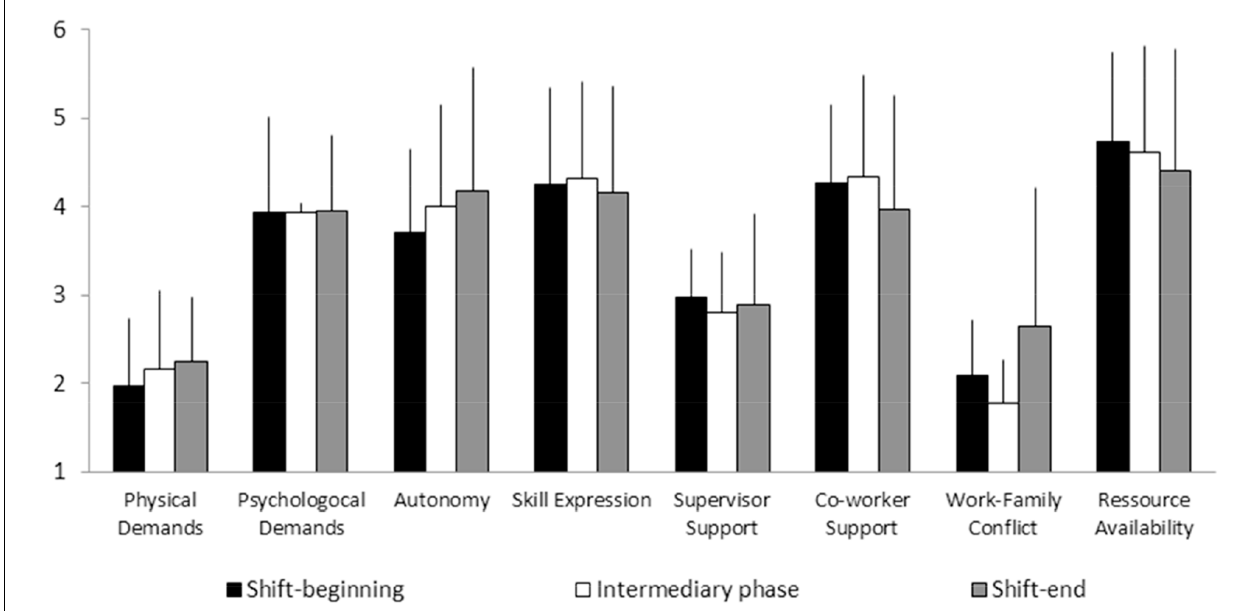
FIGURE 3 | Job characteristics (mean ± SD) perceived byATCs on three